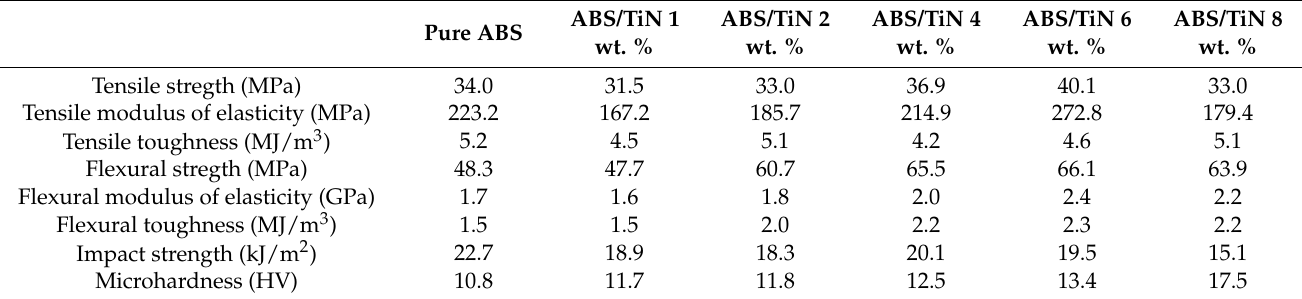
Table 2. Summary of the mechanical test